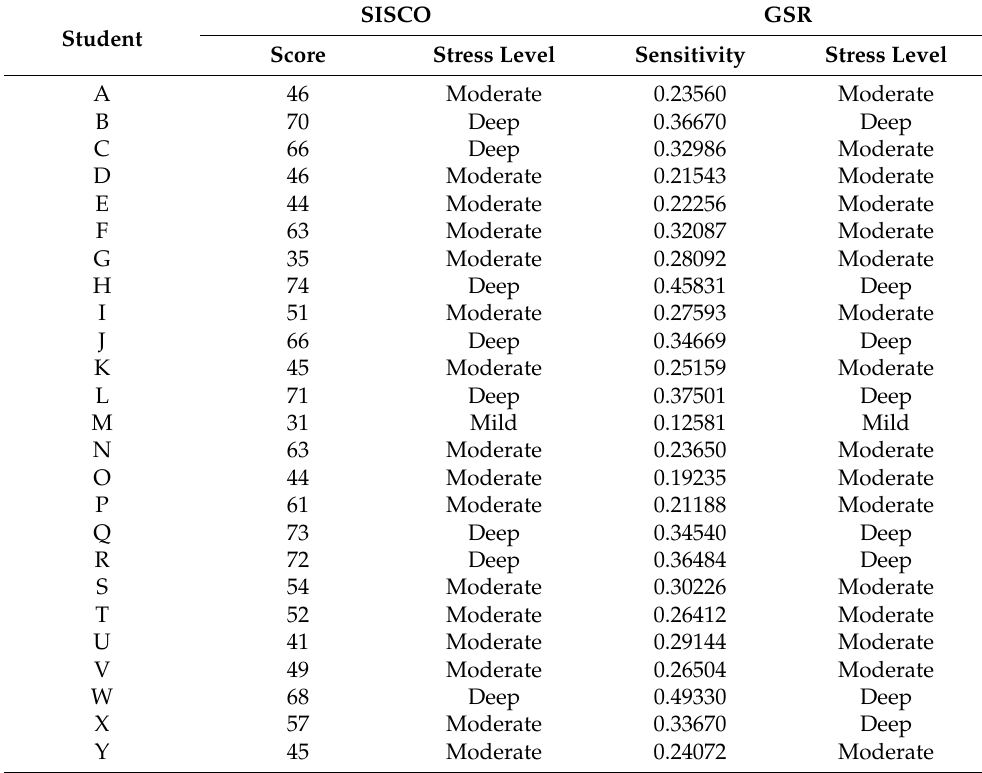
Table 3. Comparison among SISCO inventory and Galvanic Skin Response (GSR)